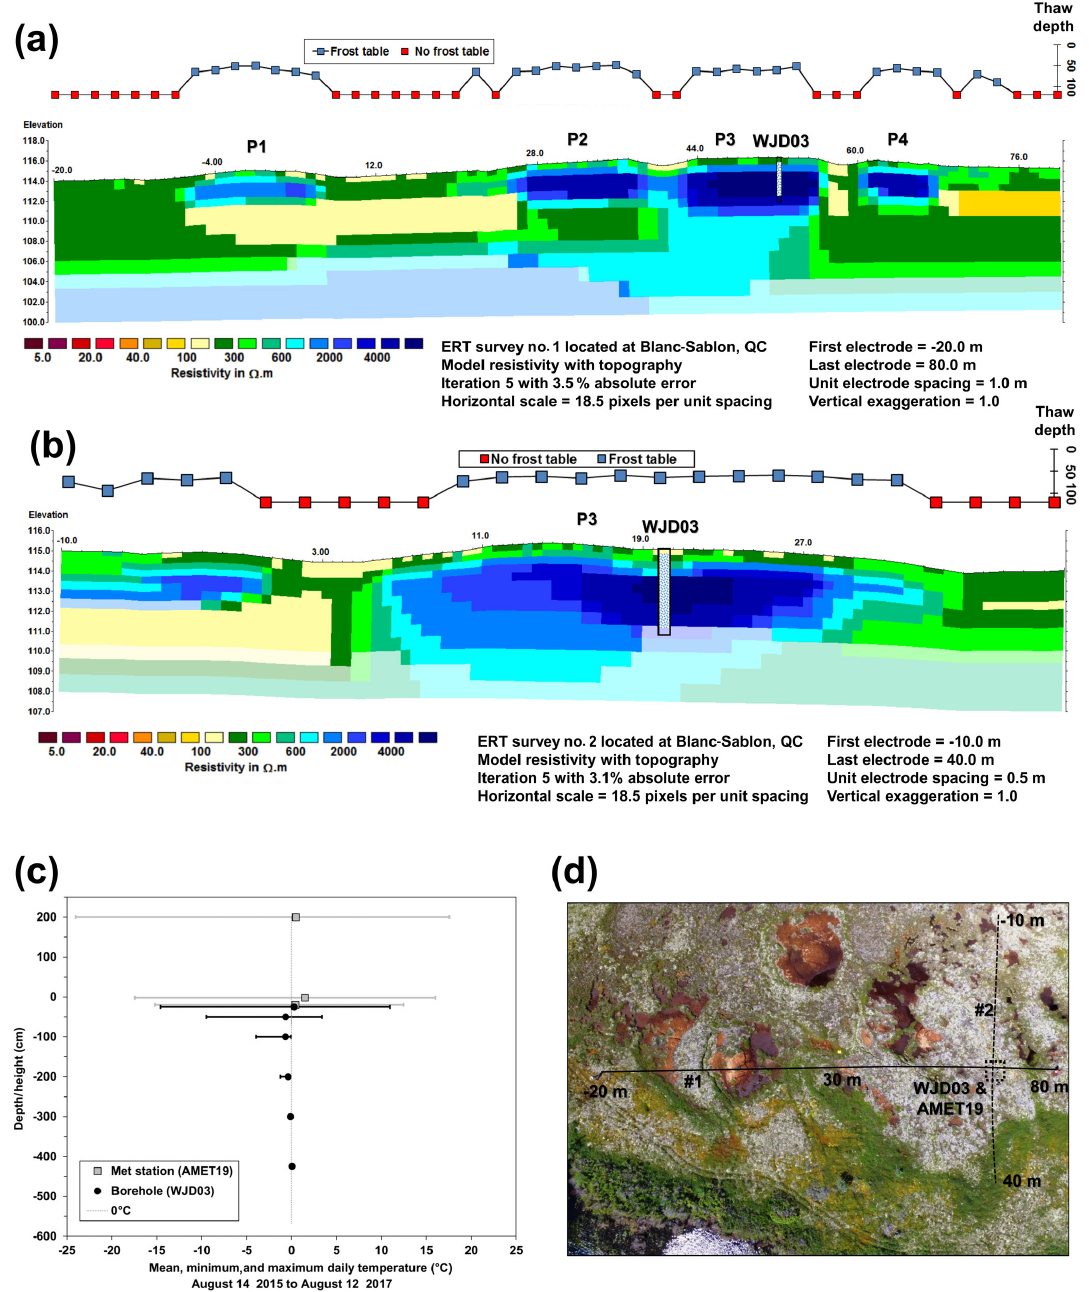
Figure 3. Peatland permafrost at Blanc-Sablon. Frost tables and modelled resistivities on (a) ERT profile 1 and (b) ERT profile 2. Depths with permafrost in the borehole are denoted by hatching. (c) Air and ground temperature envelopes (2015–2017). (d) UAV vertical image of the site. Black lines delimit the approximate location of the ERT survey lines and text shows the start and end